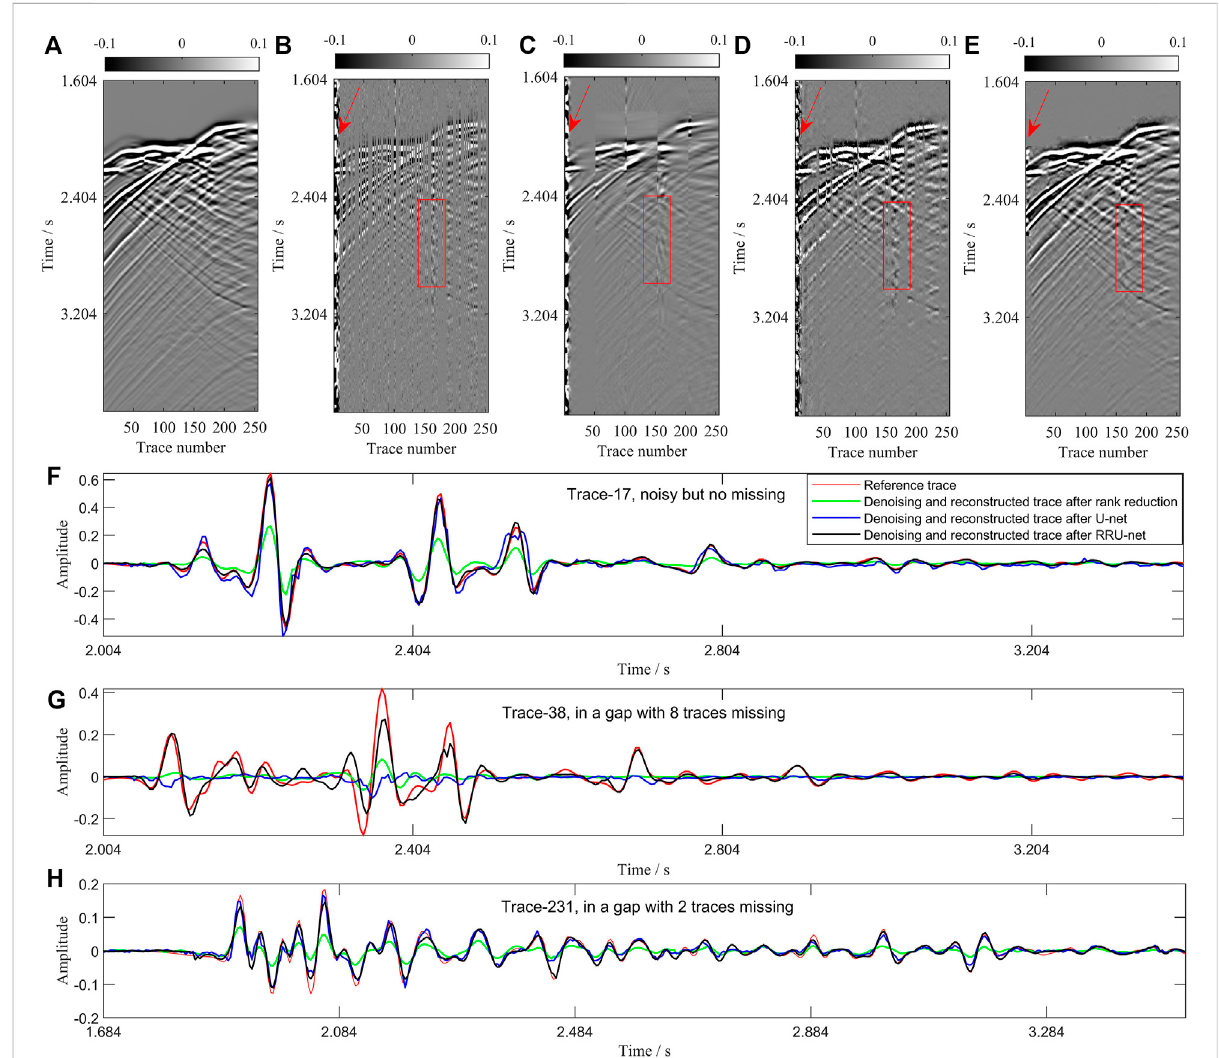
FIGURE 8 SimultaneousreconstructionanddenoisingresultsofthethreemethodsonsyntheticdatageneratedusingtheMarmousi2model. (A) Synthetic noise-free complete signal data. (B) Original gather with noise and the trace missing percentage is 63%. (C) Result by rank reduction. (D) Result by U-net. (E) Result by RRU-net. (F – H) One-dimensional waveform